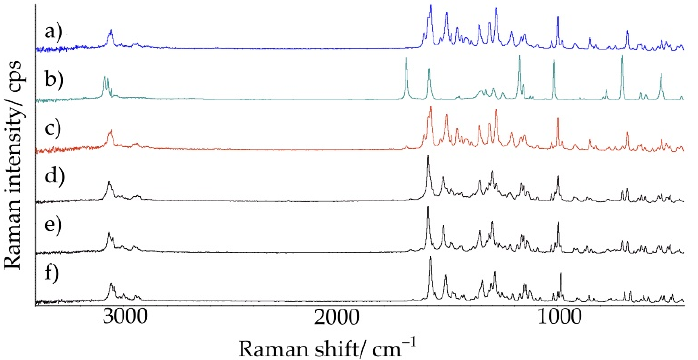
Figure 14. Raman spectra for ( a ) chlordiazepoxide, ( b ) saccharin, ( c ) chlordiazepoxide mixture with saccharin, and saccharin salts of chlordiazepoxide prepared using the following methods: ( d ) liquid-assisted grinding, ( e ) crystallization from ACN, and ( f ) crystallization from MeOH/ClMe. Table 7. Characteristic Raman shifts for chlordiazepoxide, saccharin, chlordiazepoxide mixture with saccharin, and saccharin salts of chlordiazepoxide prepared by various methods.